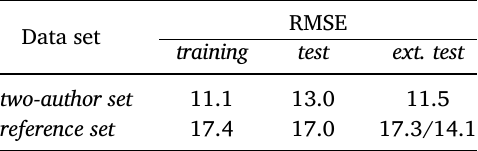
Baseline for both data